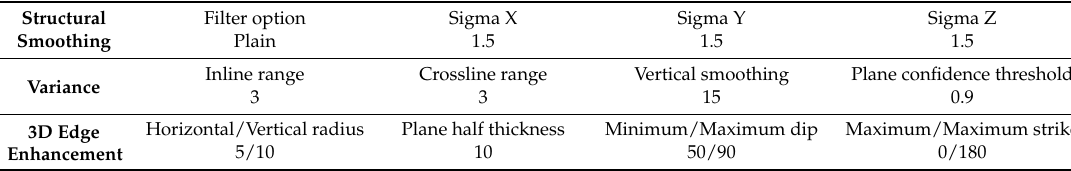
Table 1. List of parameters used in conditioning the seismic volume.